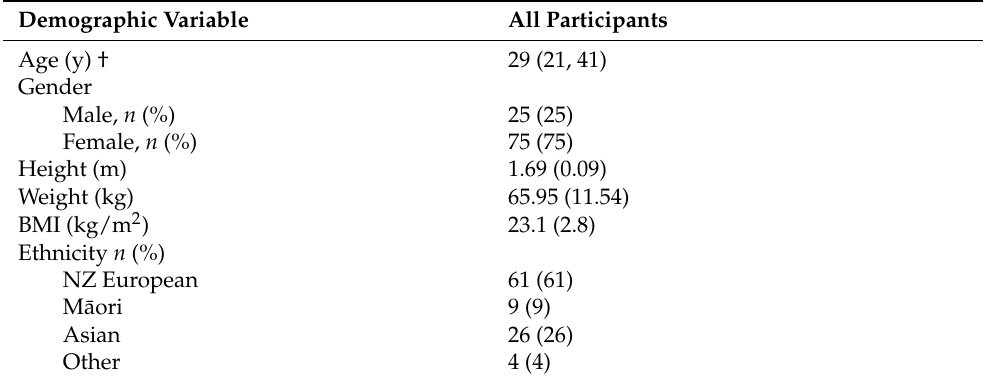
Table 2. Characteristics of study participants ( n = 100).